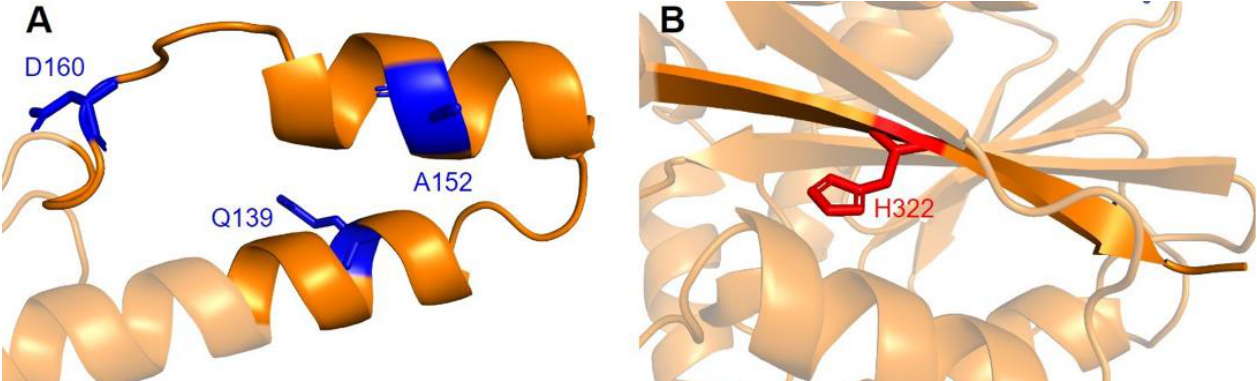
Figure 18. SNVs found in other potentially significant regions of COQ5. ( A ) The vertebrate insert (left, residues K135 to G163) and the C-terminal region (right, residues V319 to L327) highlighted on the COQ5 model. ( B , C ) Locations of SNVs locations in the vertebrate insert ( B ) and the C-terminus ( C ) are depicted. Residues are colored according to their corresponding SNVs in Figure 12.